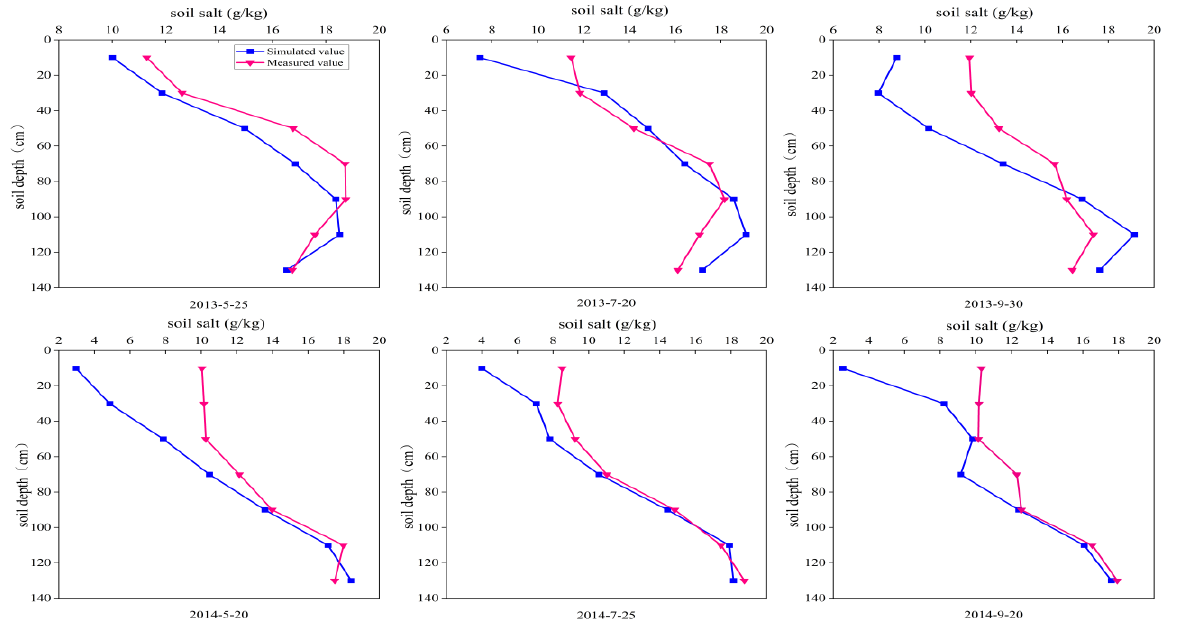
Figure 4. Comparison of the simulated and measured values of the salt content in the soil of the study area.